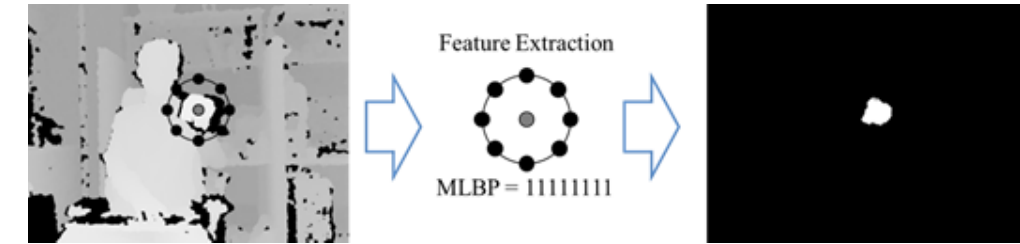
Figure 4. The resulting image of the MLBP with a threshold of 30 cm.